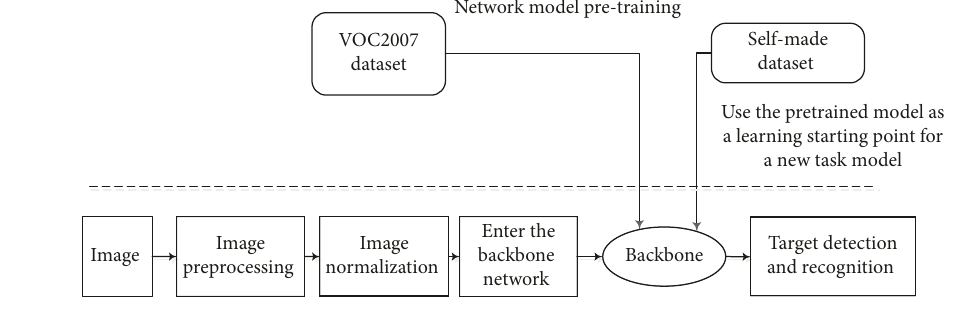
Figure 6: Pretraining model method. Table 2: Number of objects in the training and test sets.